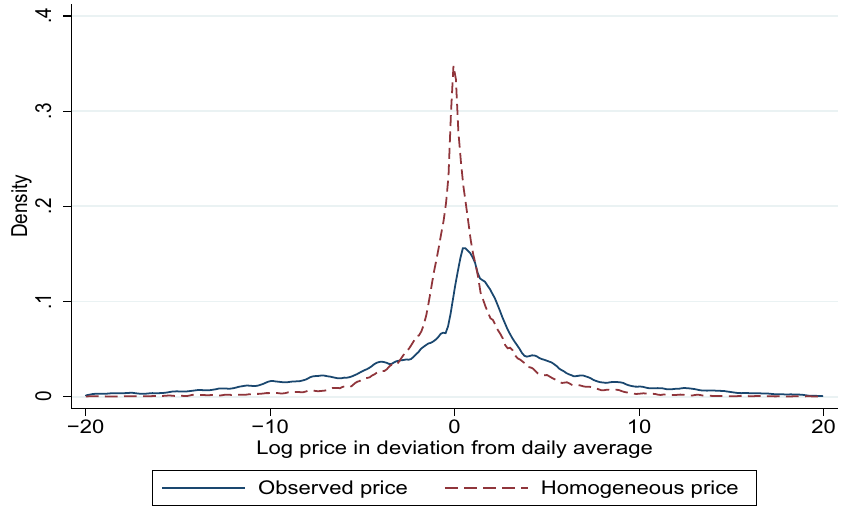
Fig. 1 Kernel density of spatial price dispersionl utility